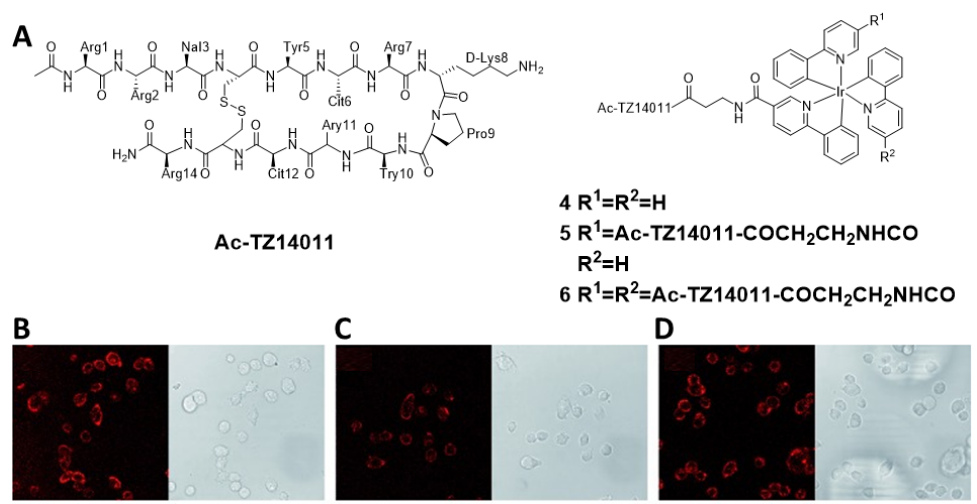
Figure 5. ( A ) Chemical structures of complexes 4−6 . Confocal images of the peptide-conjugated irid- ium( Ⅲ ) complexes in CXCR4-expressing MDA-MB-231 cells: ( B ) 4 (1 μM); ( C ) 5 (1 μM); ( D ) 6 (1 μM). Reproduced with permission from ref. [52]. Copyright 2011 John Wiley and Sons.